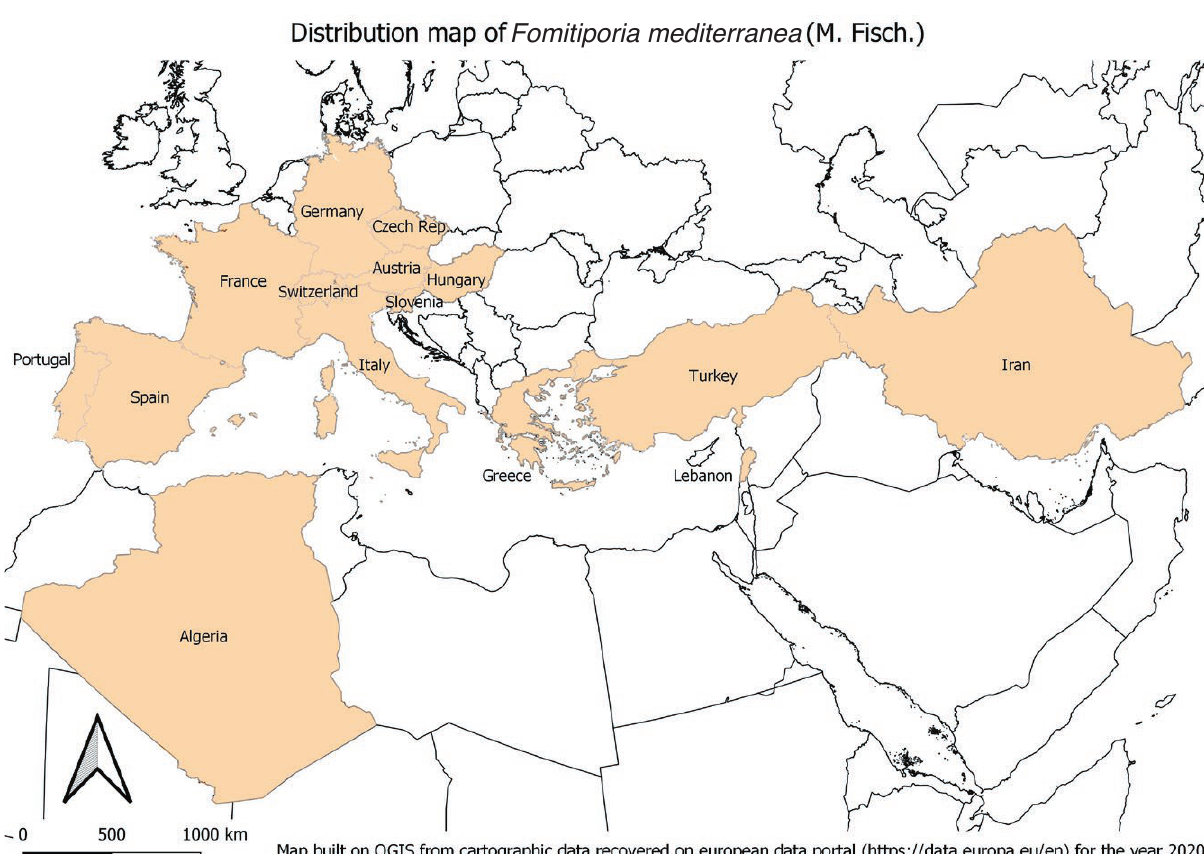
Figure 5. Distribution of Fomitiporia mediterranea , based on published reports of isolation of the fungus from grapevine, Vitis vinifera . The map was constructed using QGIS software (version 3.10.9-A